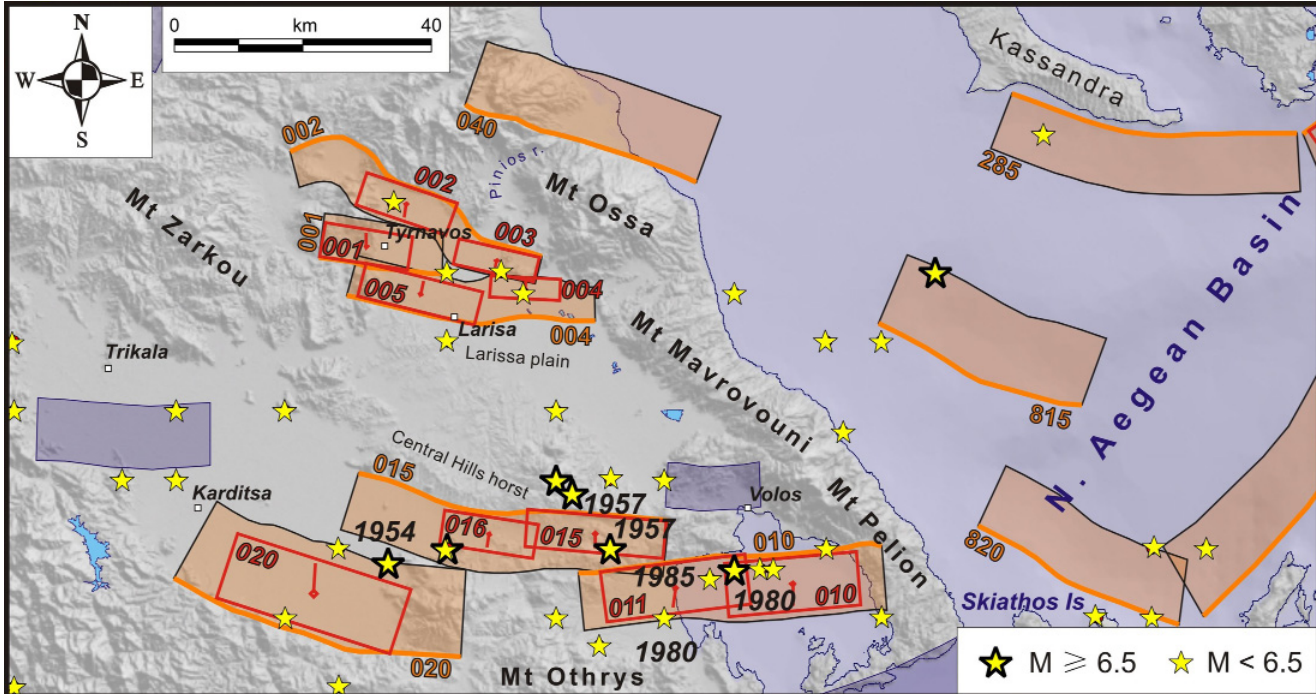
Figure 7. Map detail of the seismogenic sources belonging to the "Thessalian fault system". See Figure 1 for map location and seismogenic sources. Three-digit labels refer to the database code of the seismogenic source (ISS codes in italics). Years are provided for major earthquakes discussed in the main text (see also Table